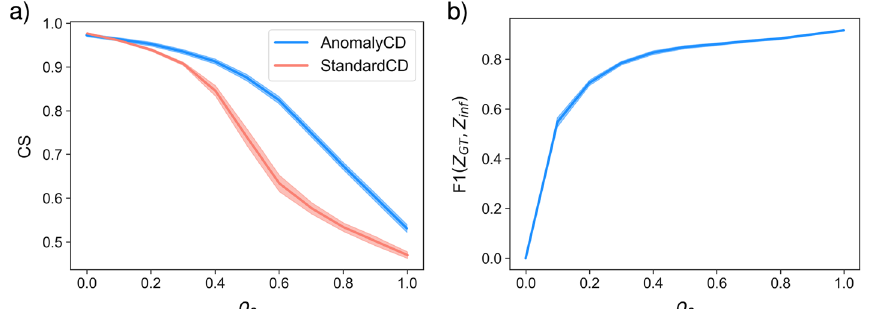
Fig. 2 Community detection and anomaly detection in synthetic networks. a Cosine similarity (CS) between ground truth and inferred communities and b the F1 score between the ground truth and the inferred anomalies. The model’s ability to detect anomalous edges increases with increasing the ratio of anomalous edges in the network. Synthetic networks with N = 500 nodes, π = 0.6 , and K = 3 communities of equal-size unmixed group membership generated with ACD. Lines and shades around them are averages and standard deviations over 20 sampled